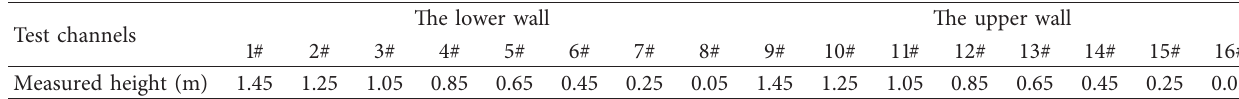
Table 2: The measured height of each test